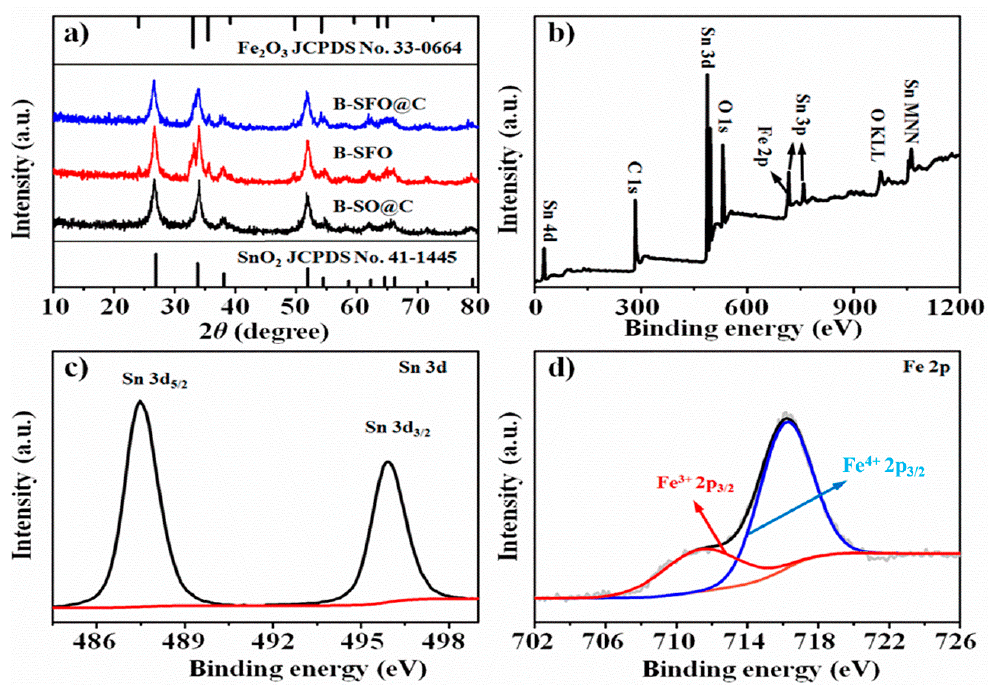
Figure 2. ( a ) XRD pattern of the samples, ( c , d ) XPS spectra of B-SFO@C sample: ( b ) survey spectrum, ( c ) Sn 3d, ( d ) Fe 2p.